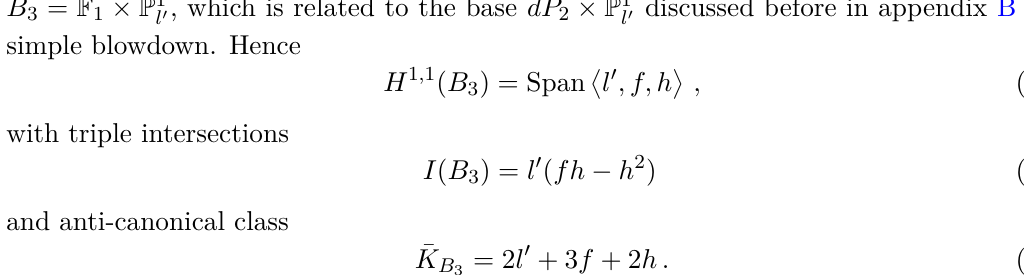
× P 1 discussed before in appendix B by a 2 l 0